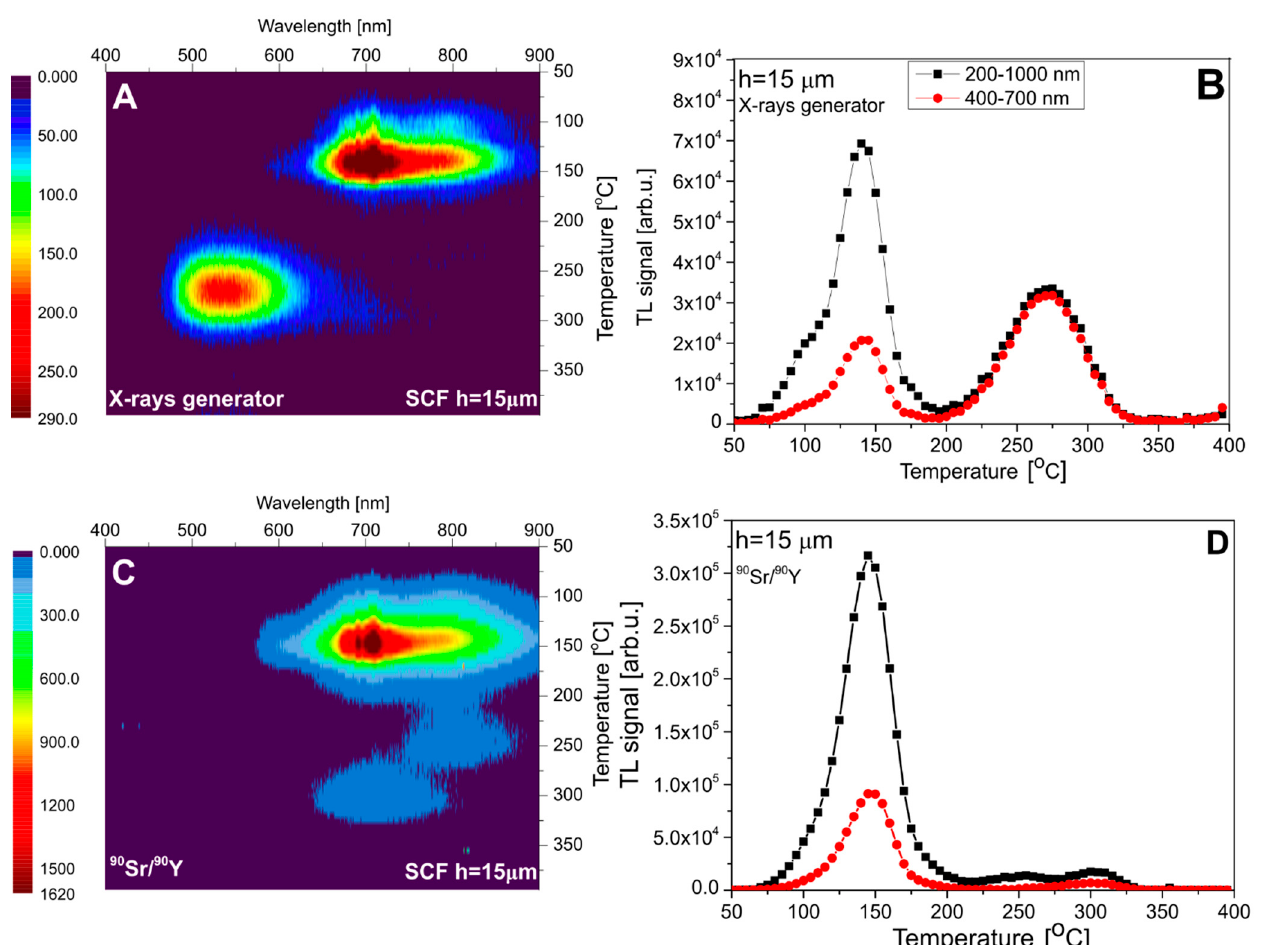
Figure 7. The emission spectra of sample #1 ( panel A —after irradiation with 15 kV X-rays and panel C —after irradiation with 90 Sr/ 90 Y) and TL glow curves ( panels B , D ). TL glow curves are taken from the spectral measurements. Table 2. Summary of the positions of TL peak maxima on the temperature and wavelength scales.